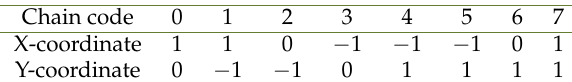
Table 2. The corresponding relationship between the adjacent points and the central points of the eight-direction chain